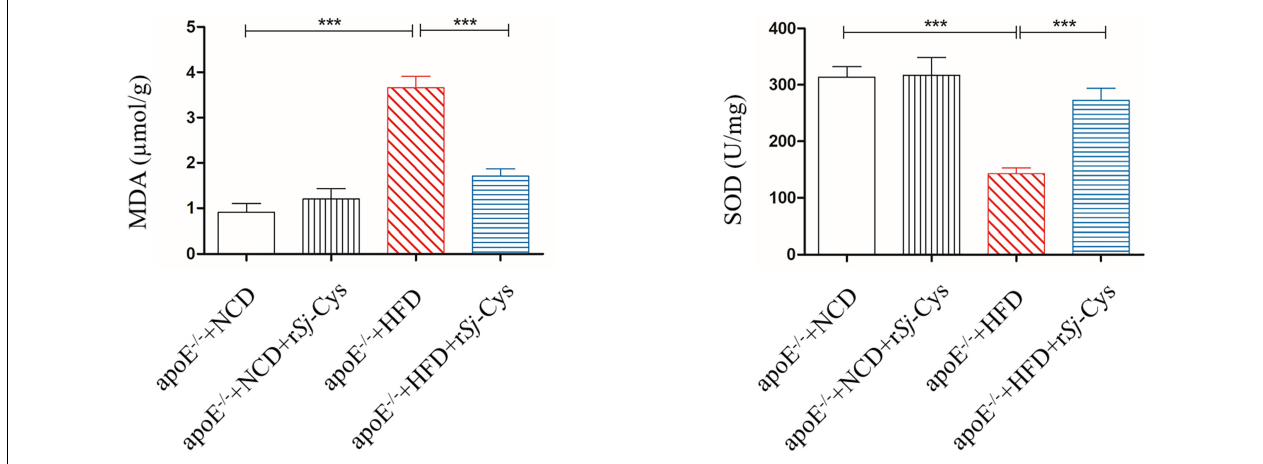
FIGURE 6 | The changes of MDA and SOD in the renal tissue after the treatment of r Sj -Cys. The data are shown as the mean ± SEM for each group ( n = 6 per group). *** P < 0.001.